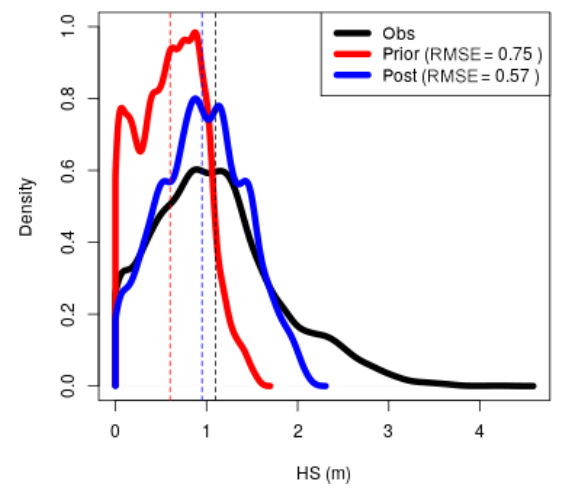
Figure 7. Density distribution plots for HS Obs, prior and posterior within the ADS footprint for 14 April 2014 (see Fig. 6). The ob- served distribution is better captured by the posterior. Dashed lines give the respective mean